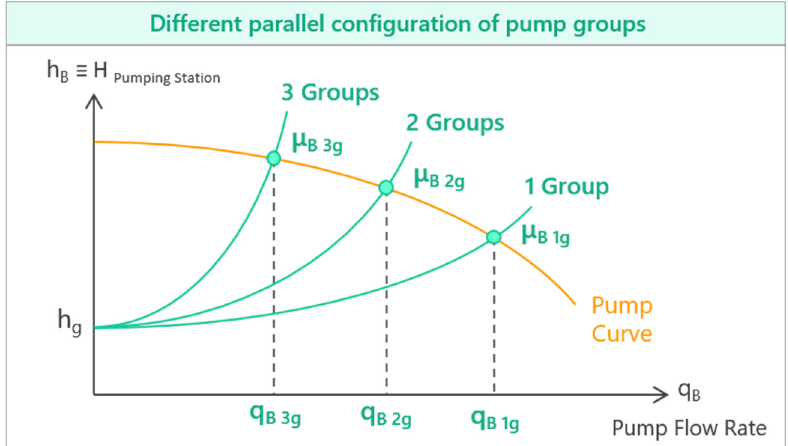
Figure 1. Different operating points of a pump depending on the number of parallel pumps active at the time. H is the pumping head. The pump’s flow rate is q B , and when there are one, two, and three groups working, it is specified as q B 1g , q B 2g , and q B 3g , respectively. Finally, µ B is the pump efficiency, and it is once again specified for the number of active